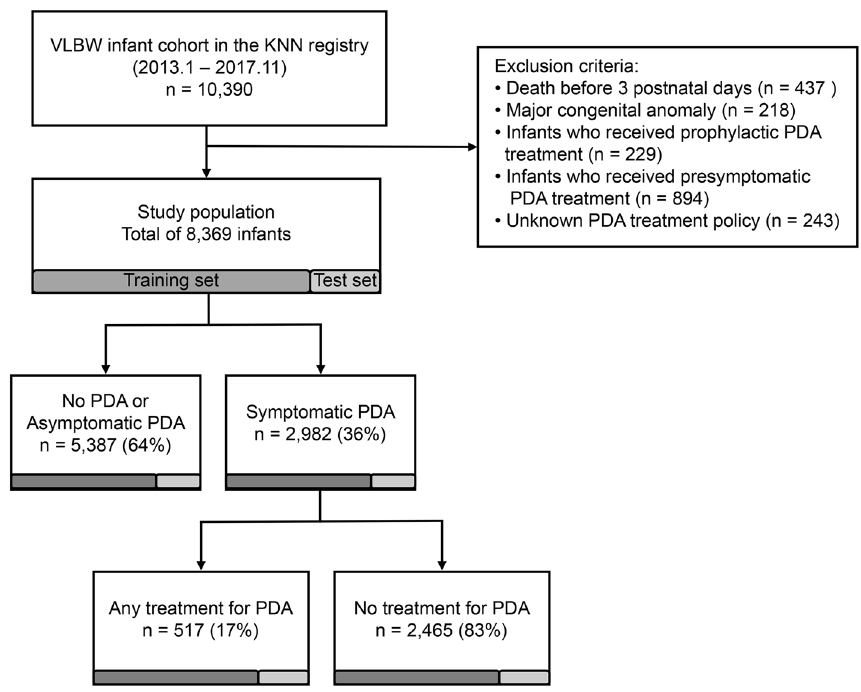
Figure 1. The study population was identified using a subsequent flowchart of the study. VLBW infants, very low birth weight infants; KNN, Korean Neonatal Network; PDA, patent ductus